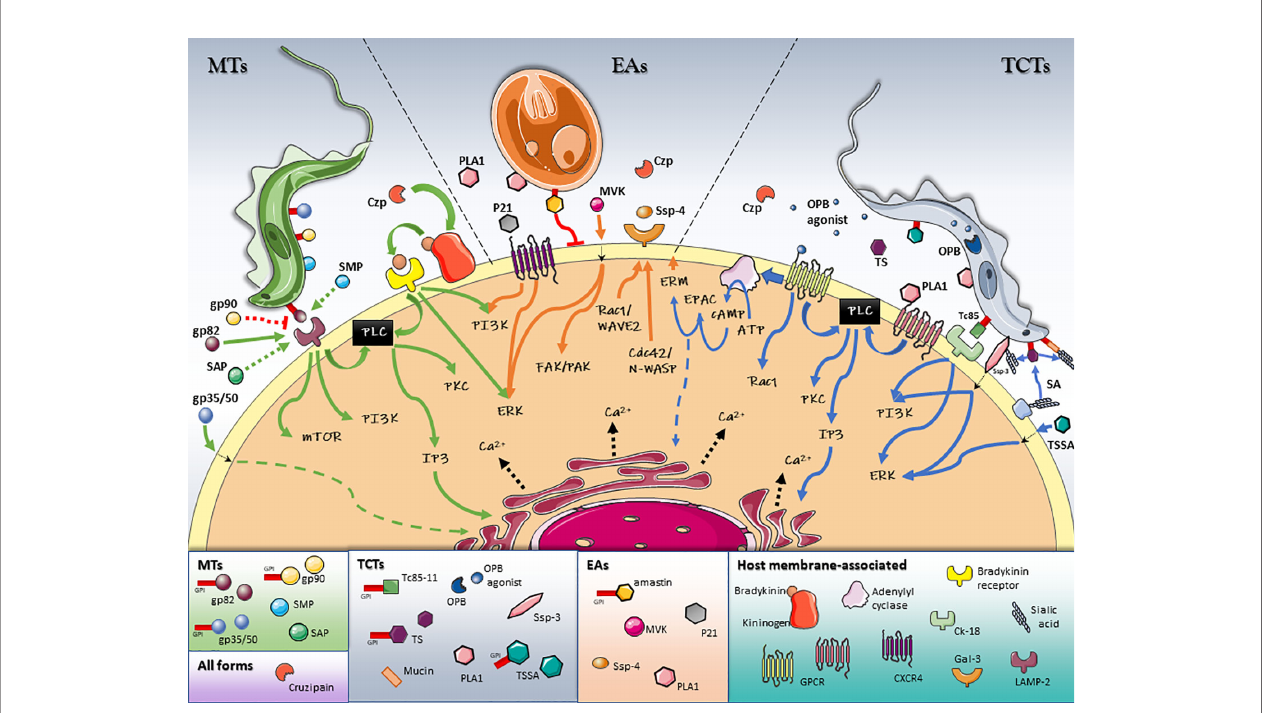
FIGURE 1 | Schematic model of T. cruzi/host cell protein interactions and activated signaling pathways during invasion. Stage-speci fi c Surface Molecules expressed on the membrane of the parasite or shed into the extracellular medium, play an essential role in the recognition, adhesion and activation of signaling pathways that lead to a successful invasion of the host cell. Figures were created using images from Servier Medical Art Commons Attribution 3.0 Unported License. (http://smart. servier.com). Servier Medical Art by Servier is licensed under a Creative Commons Attribution 3.0 Unported